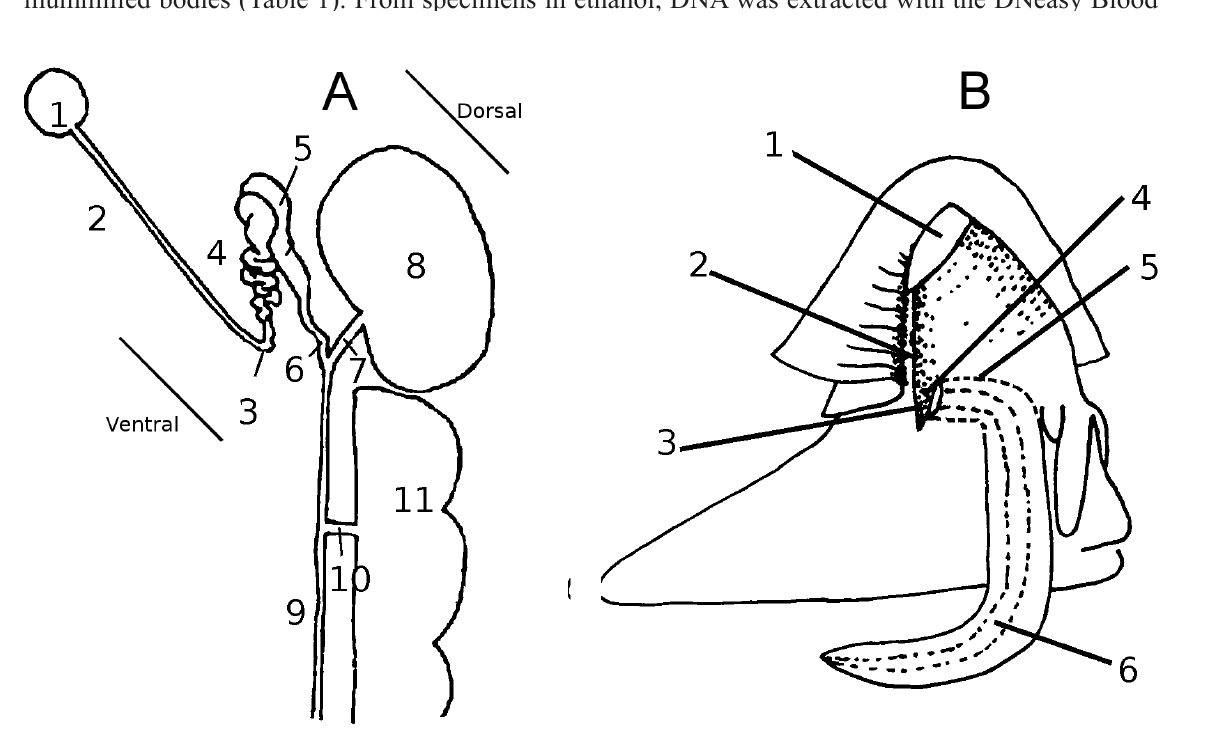
Fig. 3. Genitals of Cochlostoma Jan, 1830. A . Female genitals. 1 = ovary; 2 = visceral oviduct; 3 = proximal loop; 4 = loops of the visceral oviduct; 5 = seminal receptacle; 6 = distal oviduct; 7 = pedunculus of the bursa copulatrix; 8 = bursa copulatrix; 9 = copulatory duct; 10 = channel of the uterine gland; 11 = uterine gland. B . Male genitals. 1 = anus; 2 = groove fold; 3 = sperm pocket; 4 = penial funnel; 5 = body spermiduct; 6 = penis with the penial